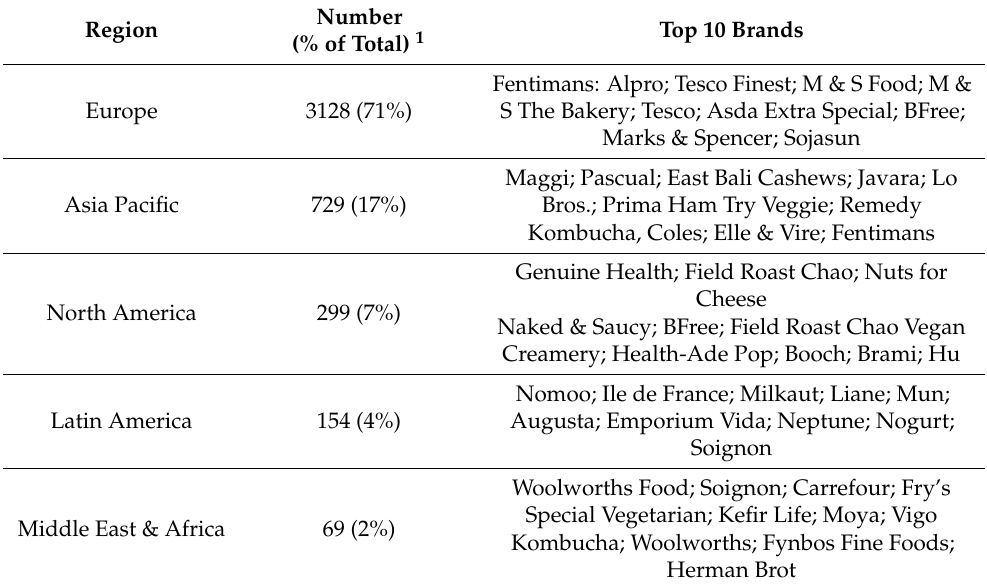
Table 2. Landscape of the global market of fermented plant-based foods.